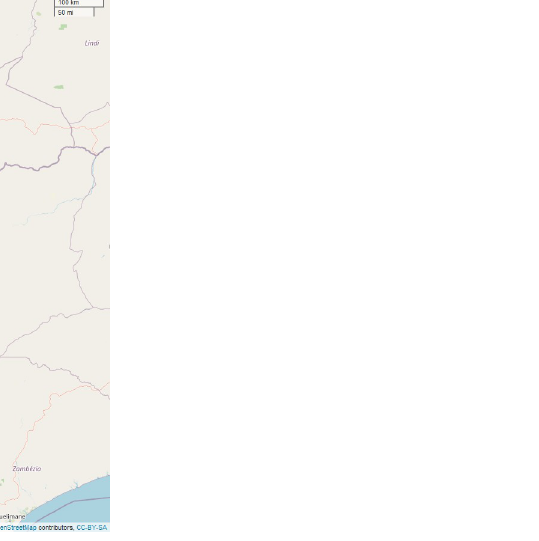
Fig 4. Map of Malawi, distance to facilities. Blue circles represent the 10km buffer area around rural clusters, green circles represent the 5km buffer area around urban clusters, red dots represent health facilities providing birth services. Base map and data from OpenStreetMap and OpenStreetMap